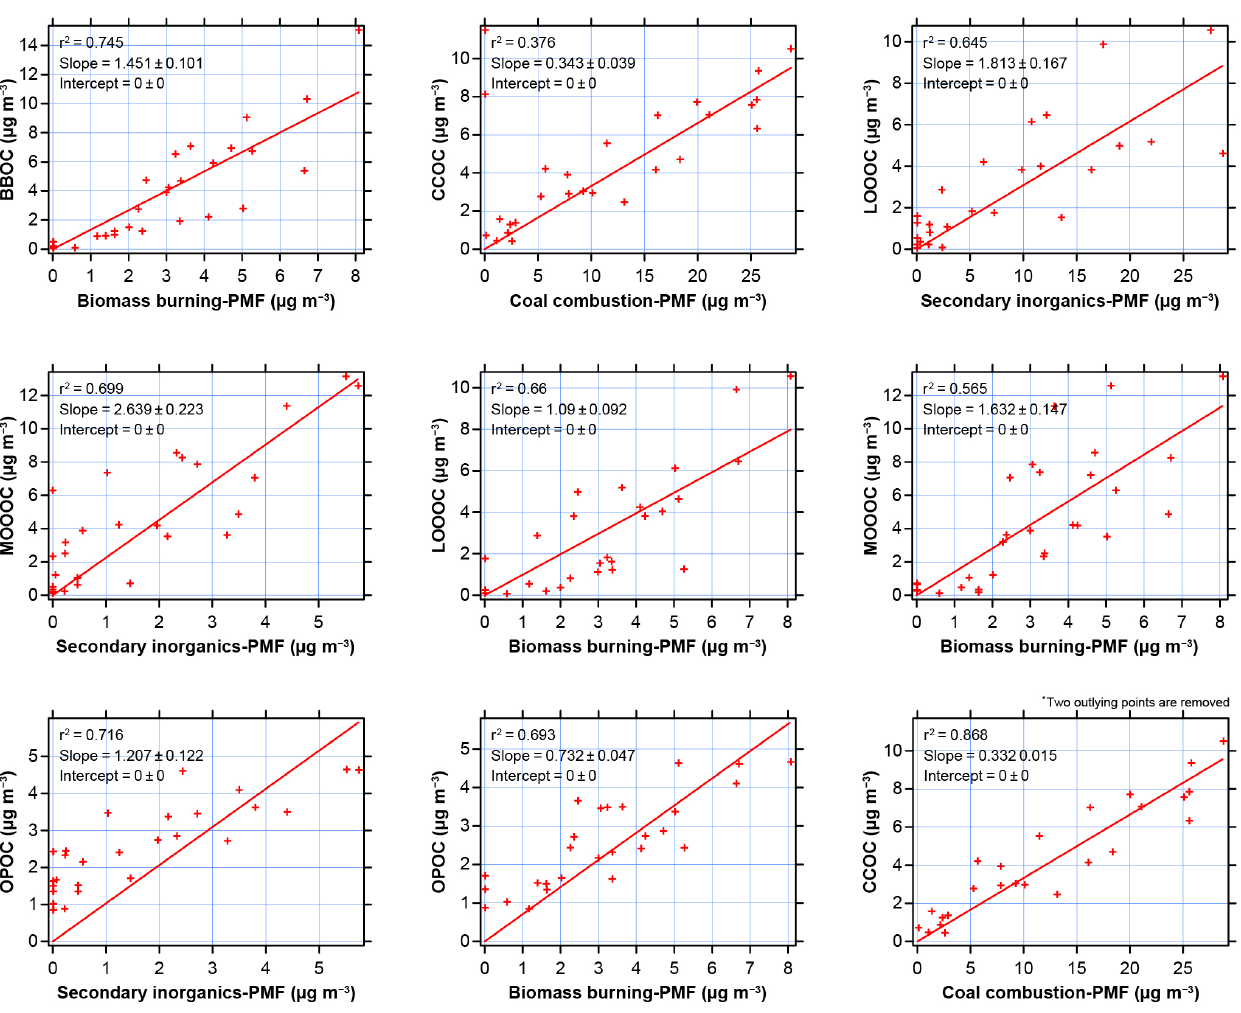
Figure 6. Correlations observed between PMF and online AMS–PMF results at IAP (winter). ∗ If two outlying points are removed from the coal combustion-PMF, correlations are markedly improved.